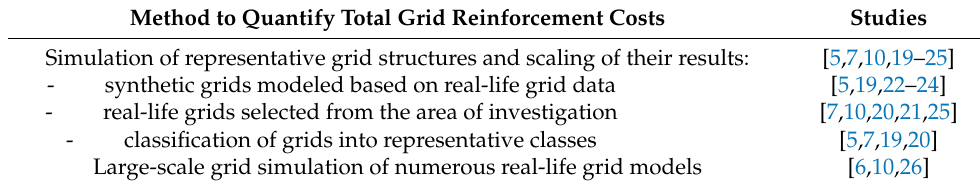
Table 1. Classification of recent studies according to their method to quantify total grid reinforcement costs for several thousand grids.